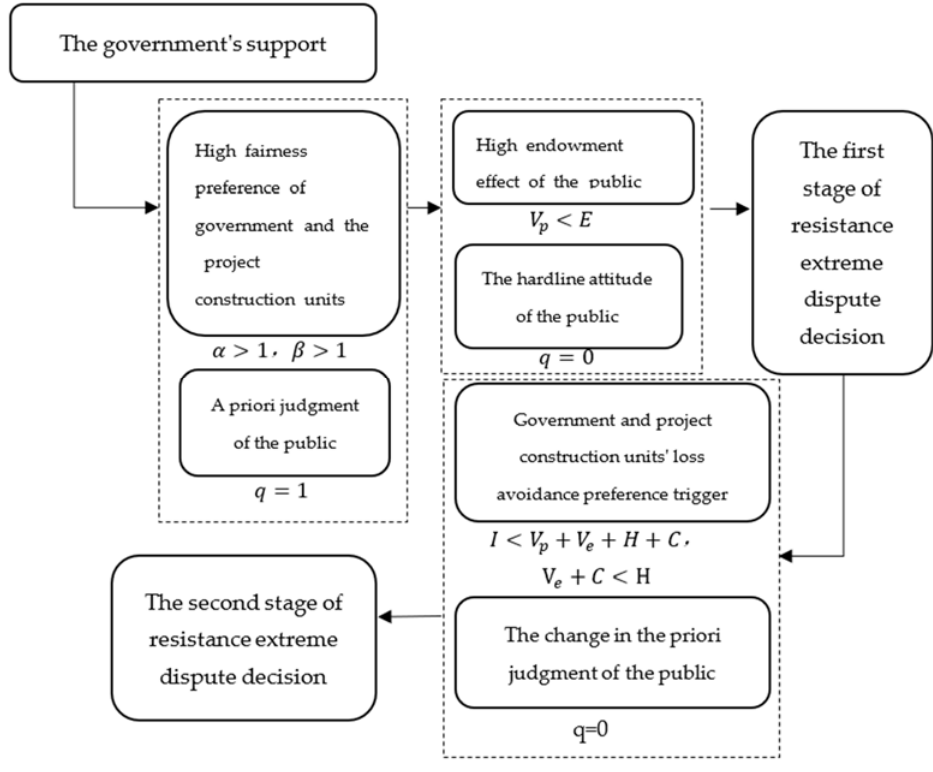
Figure 3. A path diagram for the formation of resistance-type extreme controversial decision.